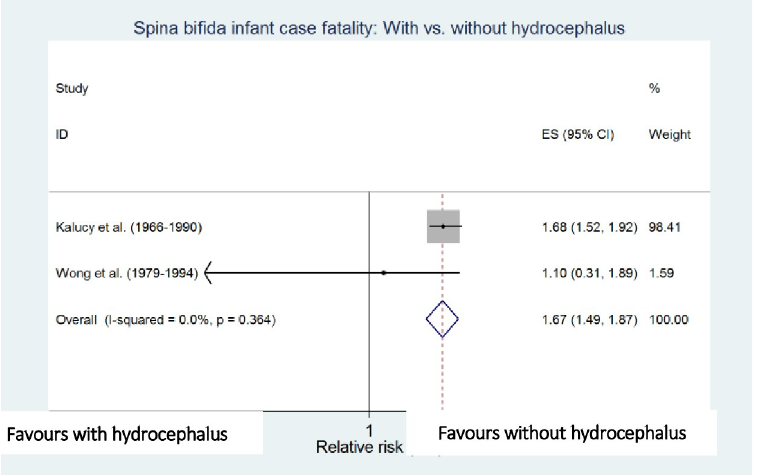
Fig 10. Presence of hydrocephalus. Spina bifida infant case fatality risk factors.